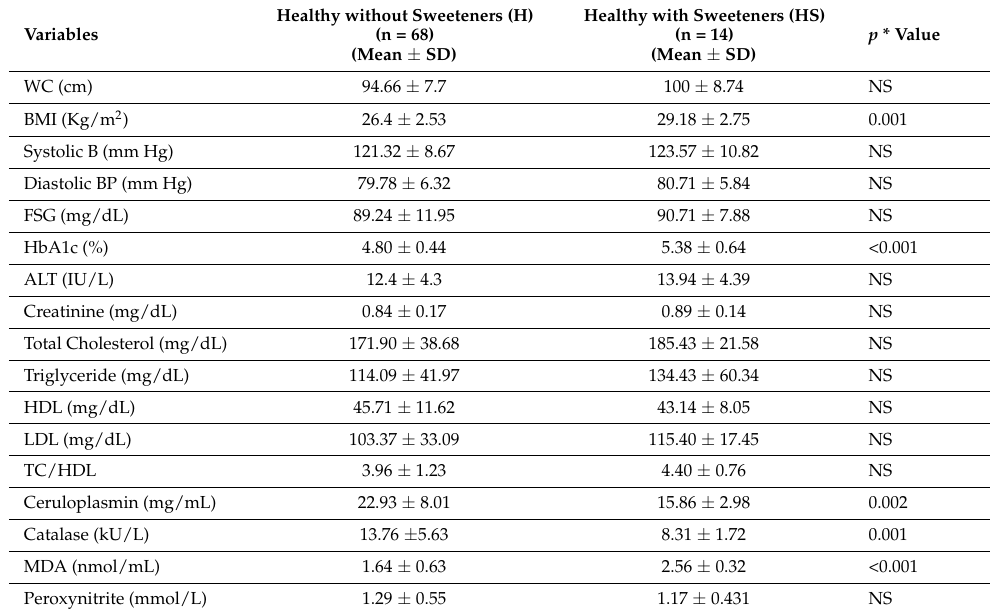
Table 2. Effect of artificial sweetener consumption among healthy individuals.